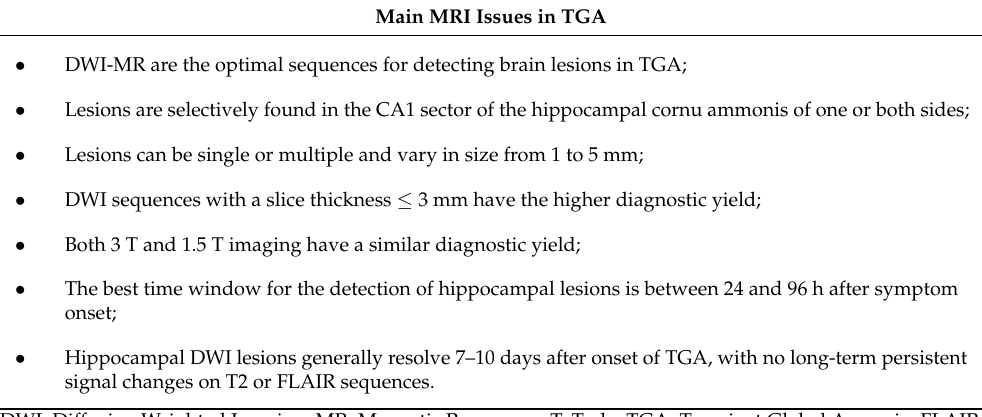
Table 2. MRI findings and parameters in